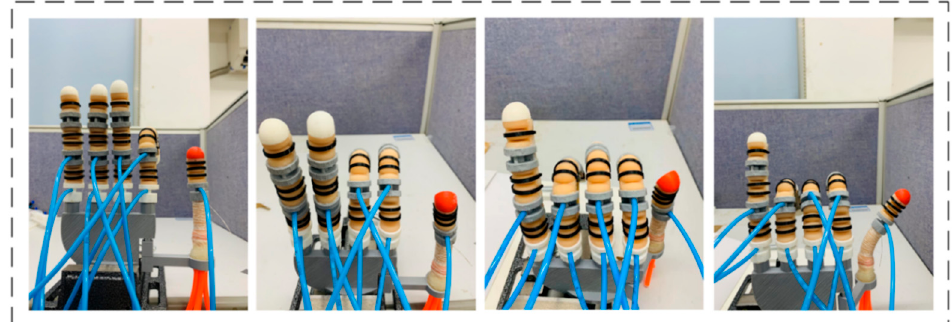
Figure 18. Bionic hand simulates human gesture operation.